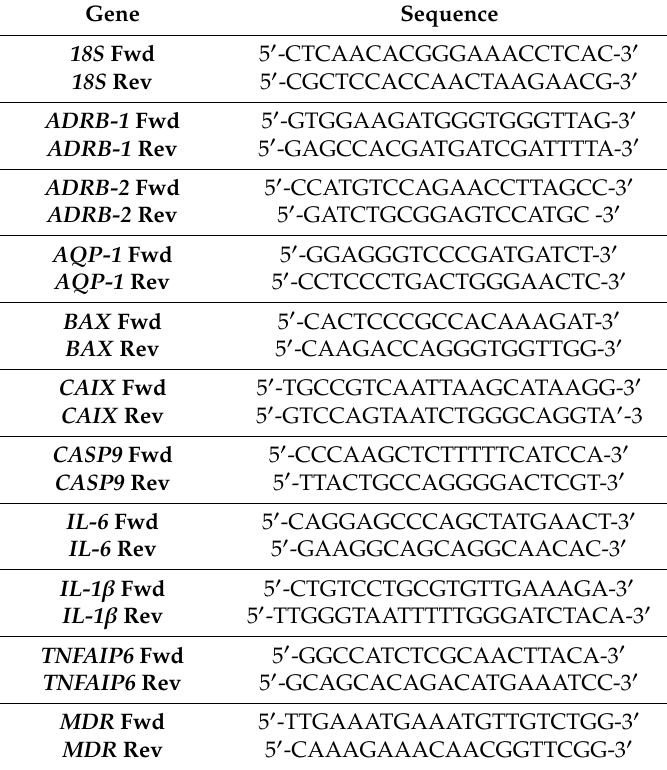
Table 3. Primers used for q-PCR